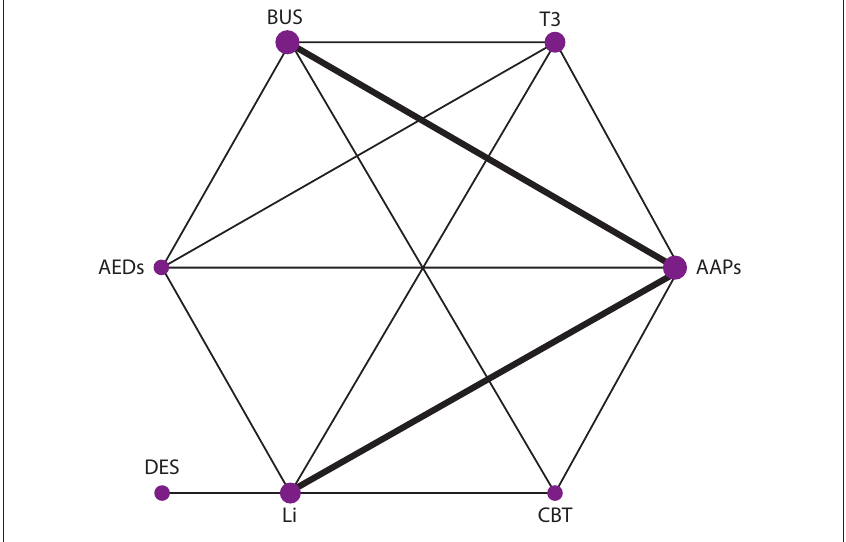
Fig. 2. Network of eligible comparisons for the multiple-treatments meta-analysis. The width of the lines is proportional to the number of patients in each pair of treatments, and the size of each node is proportional to the number of patients received in this treatment. (BUS = buspirone; T3 = tri-iodothyronine; AAPs = atypical antipsychotics; CBT = cognitive behaviour therapy; Li = lithium; TCA = tricyclic antidepressant; AEDs = antiepileptic